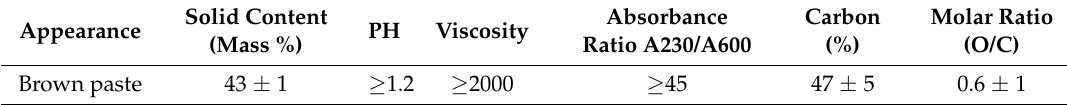
Table 2. The properties of Graphite oxide.